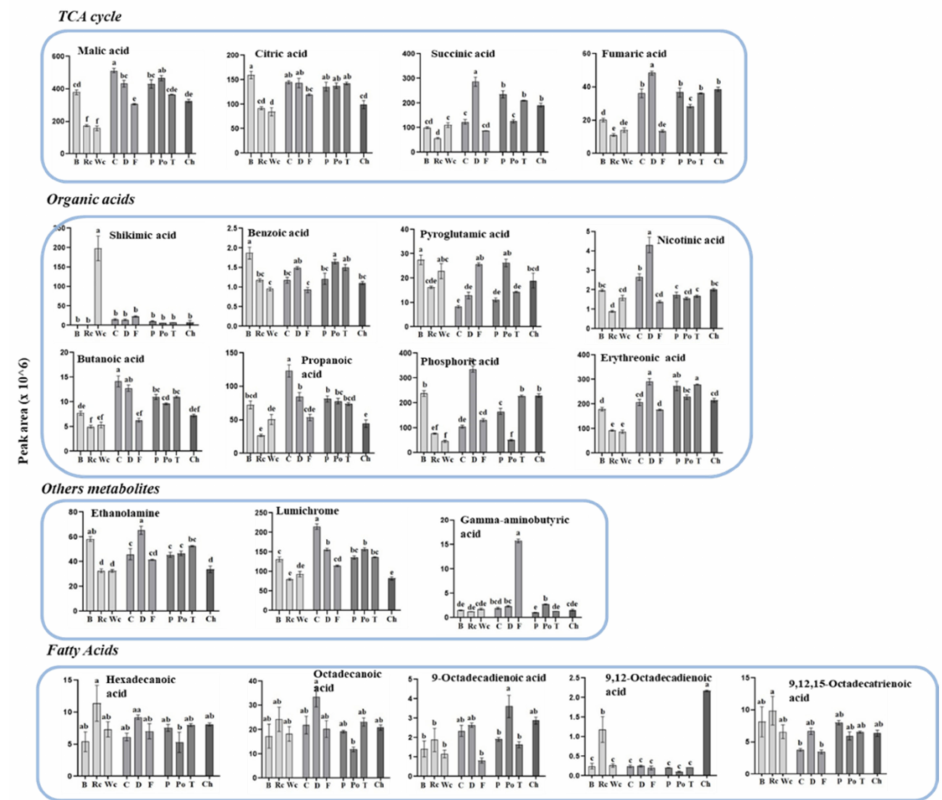
Figure 6. The levels of individual primary metabolites of organic acids, fatty acids and other acids of P. aegyptiaca grown on 10 host plants as detected by using GC-MS. Values are relative peak areas normalized to the norleucine internal standard. The Y axis represents the area of relative m/z response of each metabolite following normalization to the norleucine internal standard and the X axis represents the host plants designated as Broccoli (B), Red cabbage (Rc), White cabbage (Wc), Carrot (C), Dill plant (D), Fennel bulbs (F), Pepper (P), Potato (Po), Tomato (T) and Chickpea (Ch). Data shown are means ± SE of four replicates for each plant type. Significance is calculated according to the Turkey Kramer HSD test ( p < 0.05) and is denoted by different lowercase